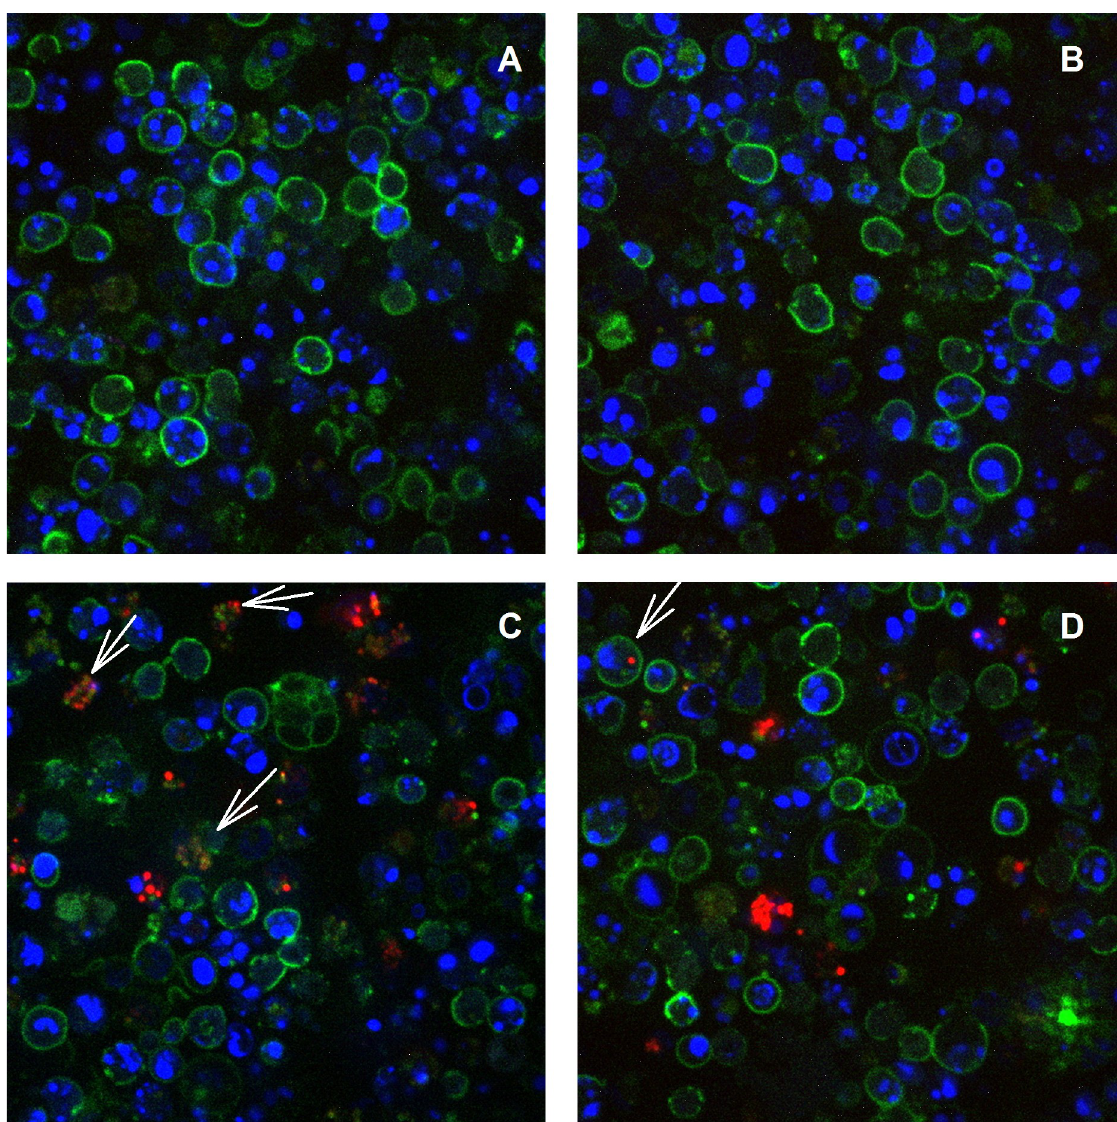
Fig 5. DC are infected in vivo by Ft LVS. C57BL/6 mice were infected with 10 5 LVS i.d. Four days after infection, single cell suspensions of splenocytes from na ï ve (panels A and B) and mCherry-LVS infected mice (panels C and D) were depleted of B and T cells using magnetic beads, and the resulting cells were analyzed by confocal microscopy. CD11c + cells (green) were identified according to the surface marker. LVS-mCherry was identified as red, and all cells were counterstained with DAPI (blue) to identify nuclei. Arrows indicate mCherry-LVS- infected CD11c + cells. Images are representative of those evaluated in two independent experiments of similar design and outcome.